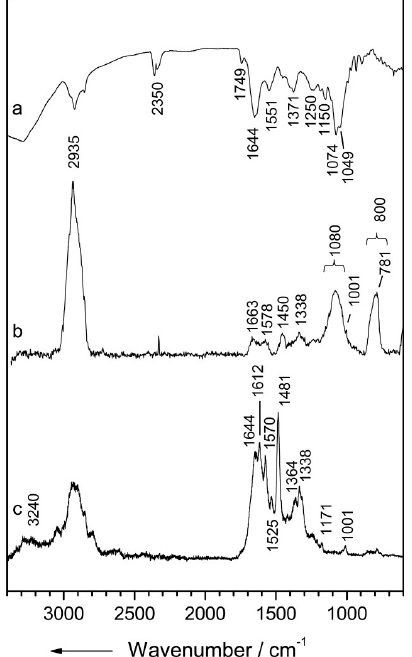
Figure 1. Vibrational spectra of Streptomyces pseudovenezuela (a) IR absorption spectrum, (b) micro-Raman spectrum with an excitation wavelength of 532 nm, and (c) UV-resonance Raman spectrum with an excitation wavelength of 244 nm. Reprinted with permission from [29]. Copyright © 2020, published by the International Society for Advancement of Cytometry.